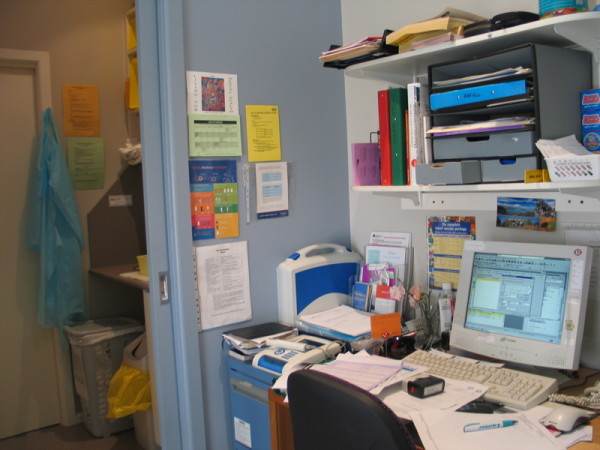
Nurse work station.